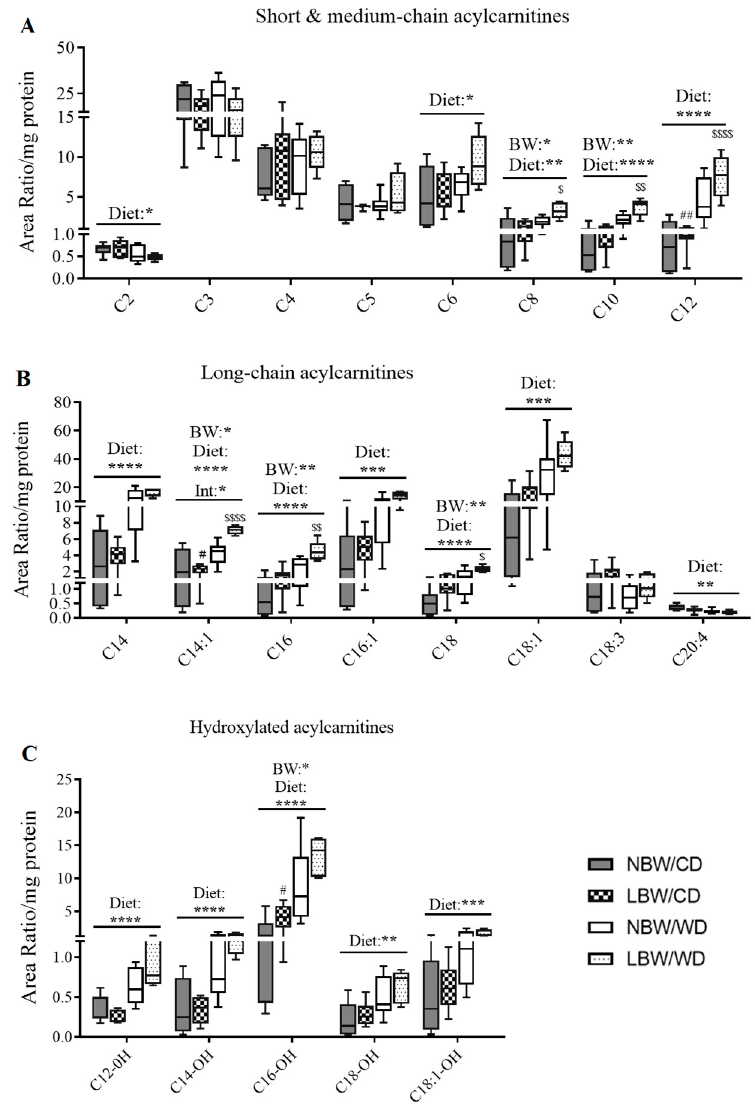
Figure 8. Acylcarnitine contents in offspring’s muscle at postnatal day 145. Short-, medium- ( A ), long- ( B ) chain and hydroxylated ( C ) acylcarnitines are presented. Data are min. to max. box and whisker plots for 5 to 8 animals/experimental group. *, **, ***, and **** for p < 0.05, p < 0.01, p < 0.001, and p < 0.0001, respectively, represent the main effect of birth weight (BW), diet (Diet), or their interaction (BW × Diet) using a regular two-way ANOVA. # and ## indicate p < 0.05 and 0.01, respectively, when comparing NBW/CD versus LBW/CD using a Bonferroni post hoc test. $ , $$ , and $$$$ denote p < 0.05, 0.01, and 0.000, respectively, for NBW/WD versus LBW/WD by Bonferroni post hoc test.